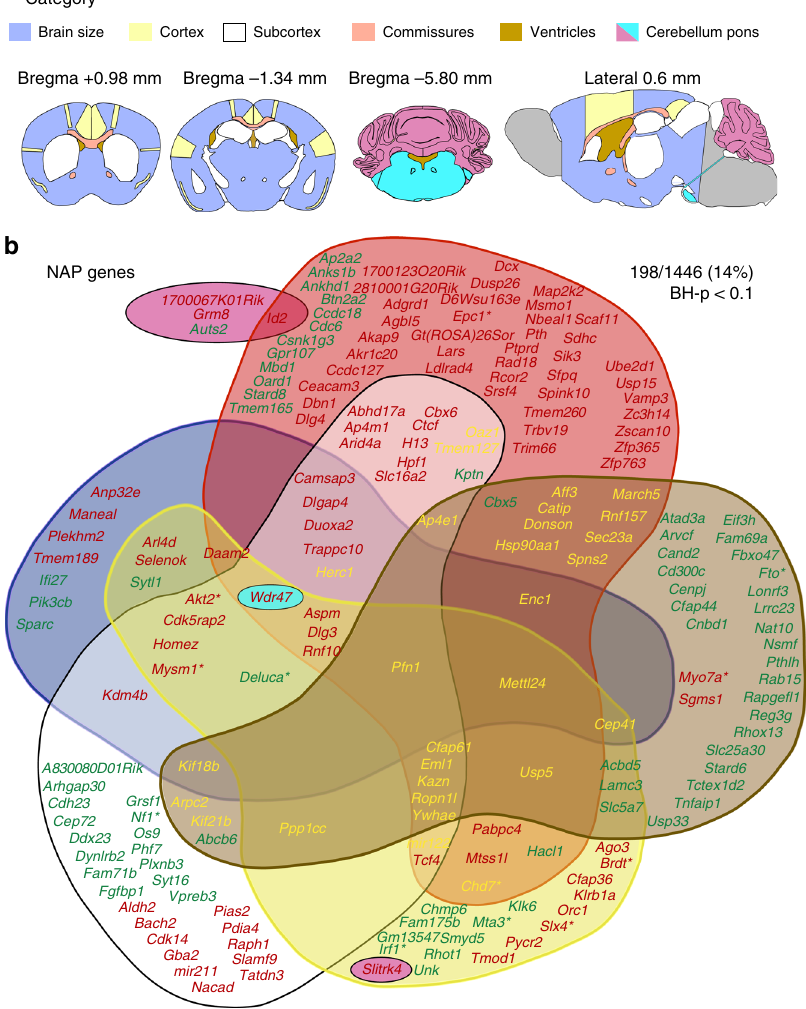
Fig. 1 Gene identi fi cation for neuroanatomical phenotypes. a One hundred and eighteen brain parameters (Supplementary Data 4; Supplementary Fig. 2) are grouped into six categories (brain size, cortex, subcortex, commissures, ventricles and cerebellum/pons) on coronal and sagittal sections at the indicated positions. b NeuroAnatomical Phenotype (NAP) genes (mouse genes whose disruptions yield a neuroanatomical defect) are positioned on each category and color-coded. Red font corresponds to decrease in structure size, green to increase, yellow to both, and asterisks refer to the 6-week